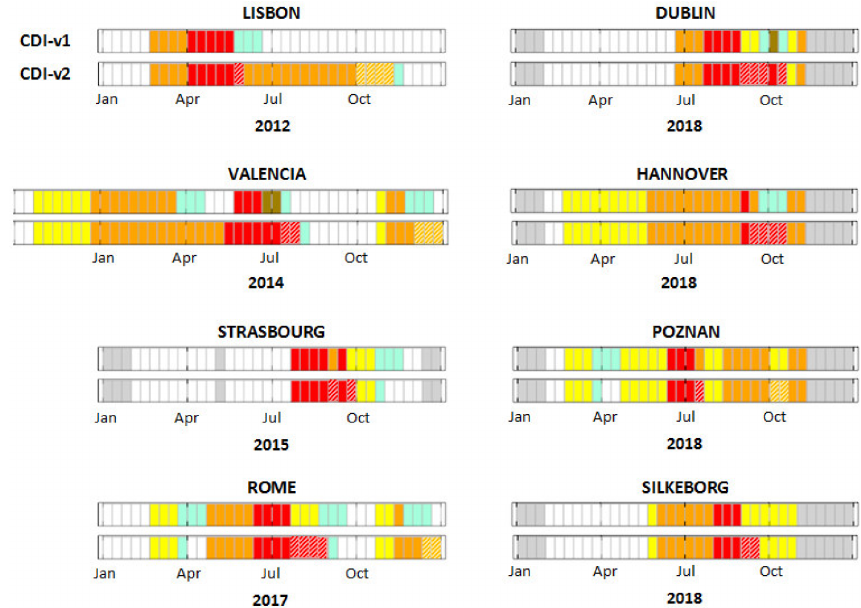
Figure 6. Time series of CDI-v1 (upper lines) and CDI-v2 (lower lines) for different test sites under drought between 2012 and 2018, as documented in the analytical drought reports in EDO (https://edo.jrc.ec.europa.eu/edov2/php/index.php?id=1051, last access: January 2021). See Figs. 1 and 4 for the corresponding legends. The labels on the x axis correspond to the beginning of the month.